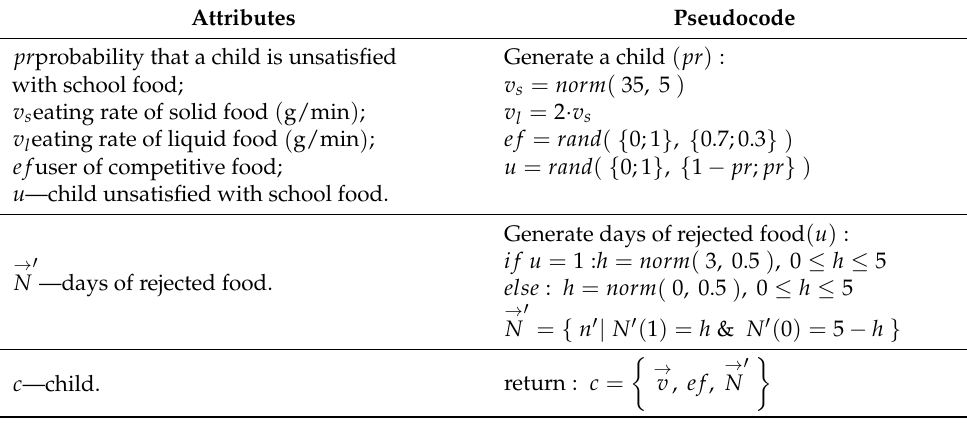
Table 7. Pseudocode for child generation.